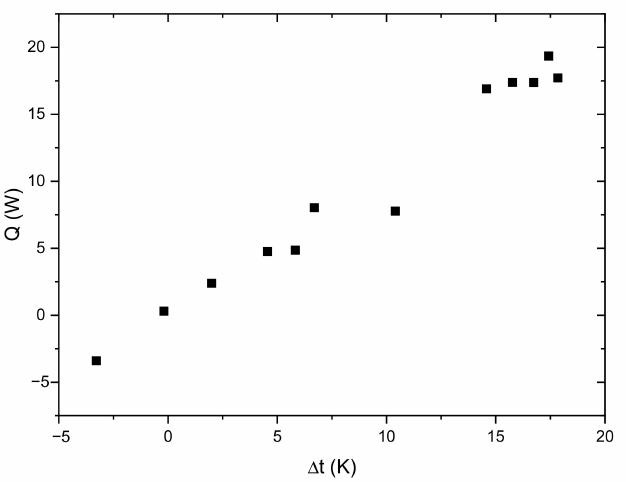
Figure 17. The measured heat flow rate Q as a function of difference between surrounding tempera- ture and average HTF temperature in the steady-state